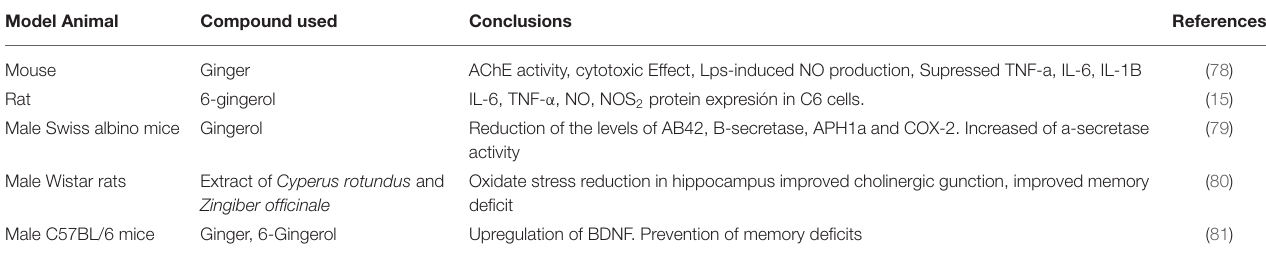
TABLE 1 | Preclinical studies of ginger and Alzheimer’s disease. Model Animal